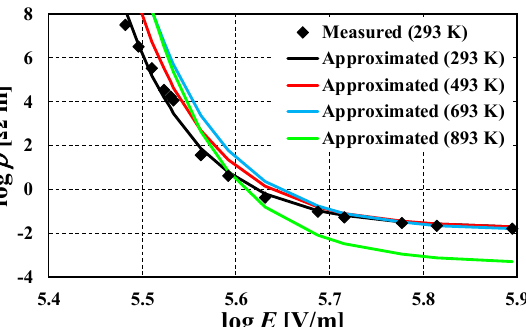
Figure 2. - E properties of the MOV element at temperatures of T = 293, 493, 693, and 893 K drawn using the proposed expressions: Equations (10)–(12). The measured - E property is also shown at the initial temperature of 293